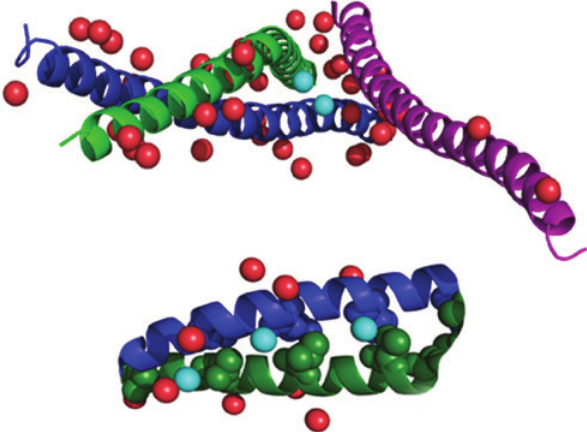
Figure 3: Crystal structure of the human short coiled coil protein (SCOC). Top panel: the three chains form two and three stranded parallel coiled coils (blue, green and magenta) with structural water mol- ecules (red). Two water molecules (cyan) occupy the proximal side to the third coil (magenta) at the open side of dimer (blue-green). Bottom panel: magnification shows additional water molecules (cyan) at the interface of the dimer (blue-green) formed by Leu residues as ‘knobs’ (shown as spheres). Reproduced from PDB entry 4bwd; PMID: